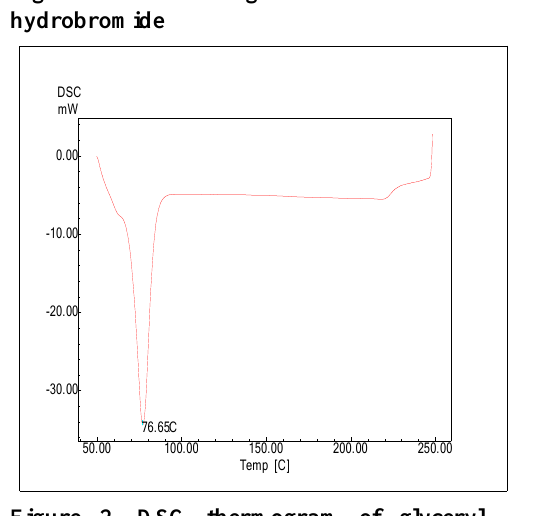
Figure 1. DSC thermogram of darifenacin hydrobromide